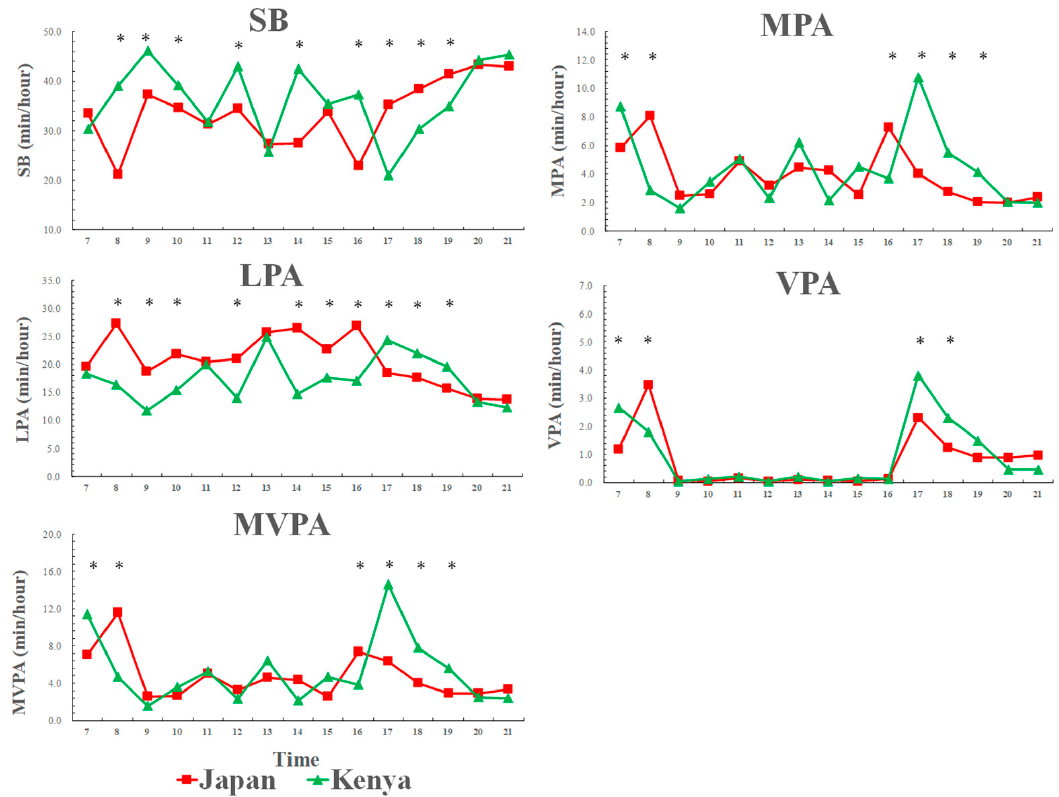
Figure 1. Weekday physical activity and sedentary behavior patterns across a day among Kenyan and Japanese